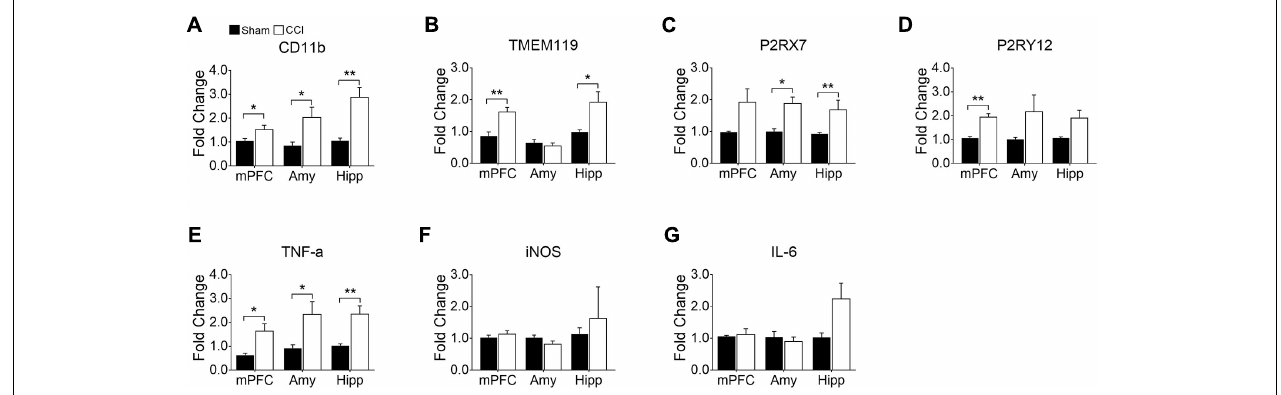
FIGURE 5 | CCI-induced neuropathic pain induced changes in gene expression related to microglial activation and depression in the mPFC, amygdala (Amy), and hippocampus (Hipp) at delayed time points (8 weeks) post-injury. qRT-PCR showed significantly increased expression of (A) CD11b, (B) TMEM119, (C) P2RX7 (D) P2RY12, and (E) TNF- α in brain areas observed post-injury ( n = 3 ∼ 6, mean ± SEM, ∗ p < 0.05, ∗∗ p < 0.01). However, qRT-PCR showed no significant differences in (F) iNOS and (G) IL-6 expression levels between CCI and sham groups post-injury ( n = 3 ∼